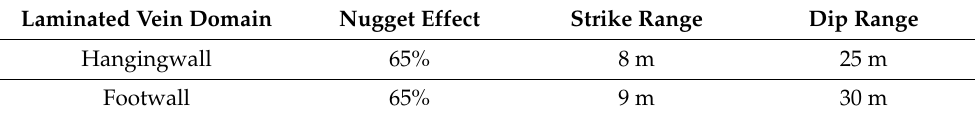
Table 5. Variogram parameters.